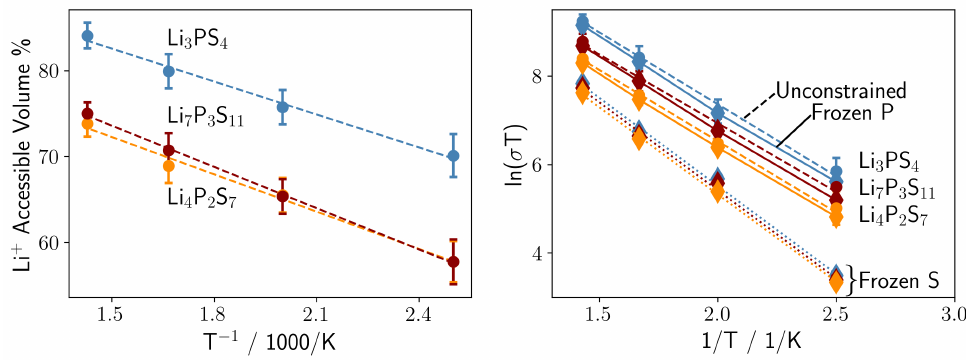
Figure 4. ( Left panel) Accessible volume of lithium during MD simulations at various temperatures: Li 3 PS 4 (blue dashed line), Li 7 P 3 S 11 (red dashed line), and Li 4 P 2 S 7 (orange dashed line). ( Right panel) Li ion conductivity with frozen sulfur lattice (diamonds with dotted lines), with frozen phosphor lattice (diamonds with solid line) and without constraints on the sulfur lattice (dots with dashed line): Li 3 PS 4 (blue lines), Li 7 P 3 S 11 (red lines), and Li 4 P 2 S 7 (orange lines).